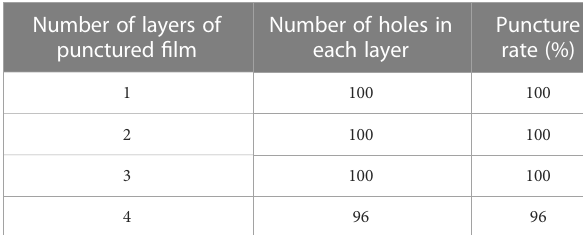
TABLE 4 Para fi lm Ⓡ membrane insertion test results. Number of layers of punctured fi